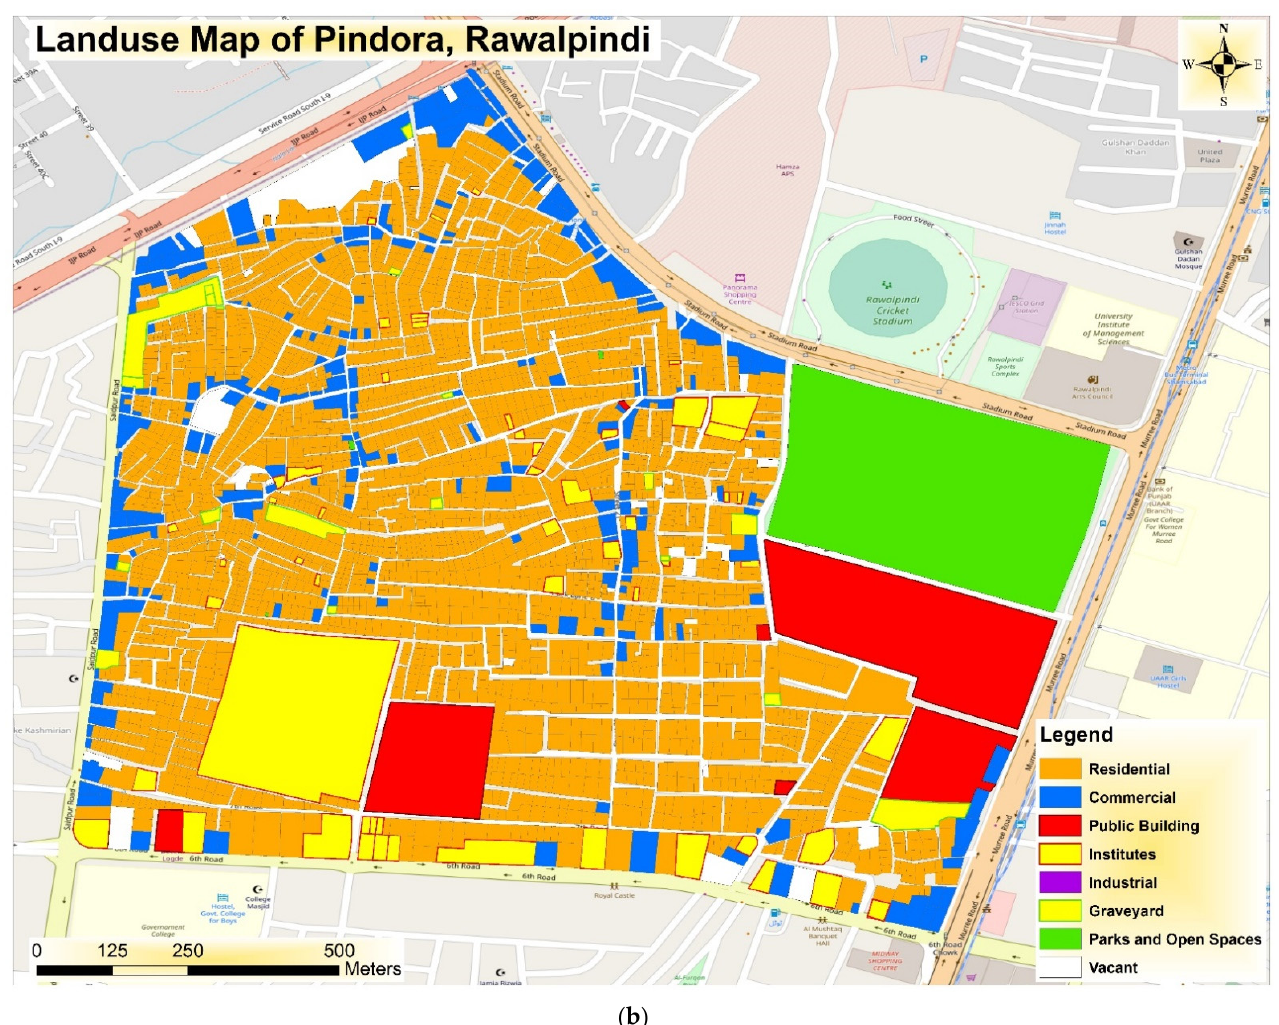
Figure 2. The two selected neighborhoods in Rawalpindi: ( a ) Satellite Town, as a sprawled neighborhood; ( b ) Pindora, as a compact neighborhood, both neighborhoods are located next to each other with different urban built environment structures by authors; adapted from Google Earth, 2021.